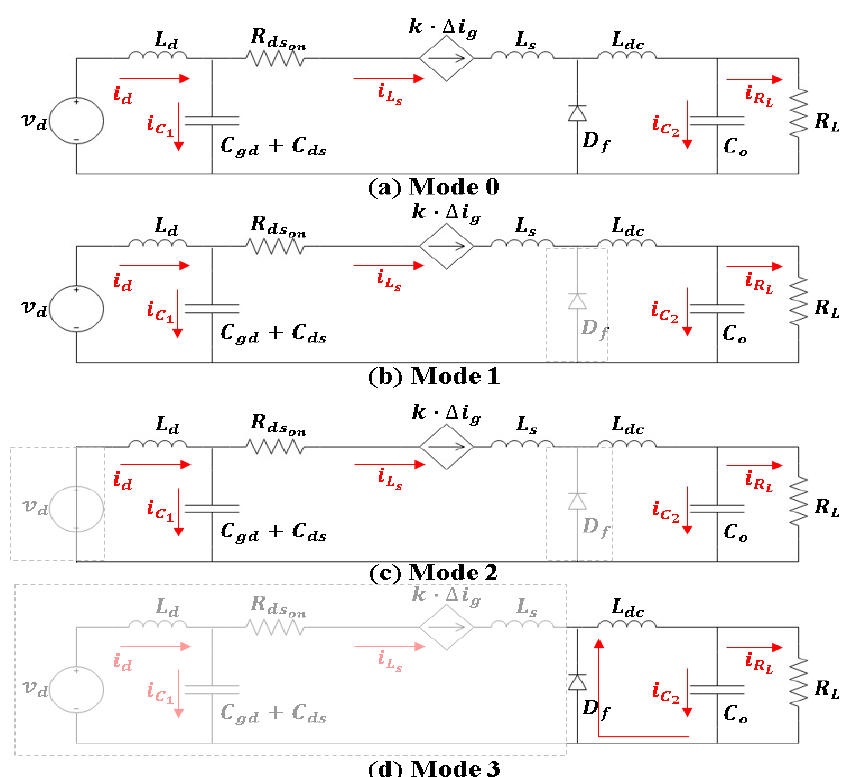
Figure 5. Modeling the drain-source circuit in the GaN FET system: ( a ) Free-wheeling, powering and resonant mode at transient state at turn on; ( b ) Powering mode at turn on; ( c ) Resonant mode at transient state at turn off; ( d ) Free-wheeling mode at turn off.